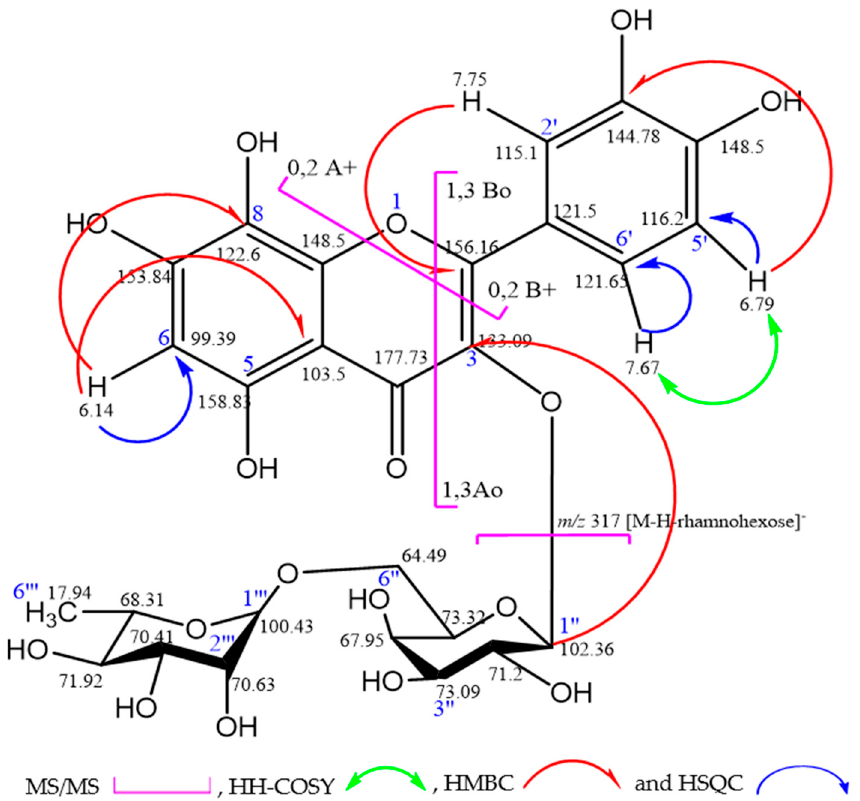
Figure 1. Selected fragmentation pattern (MS/MS) and correlations of gossypetin-3- O - β - D -robinobioside.